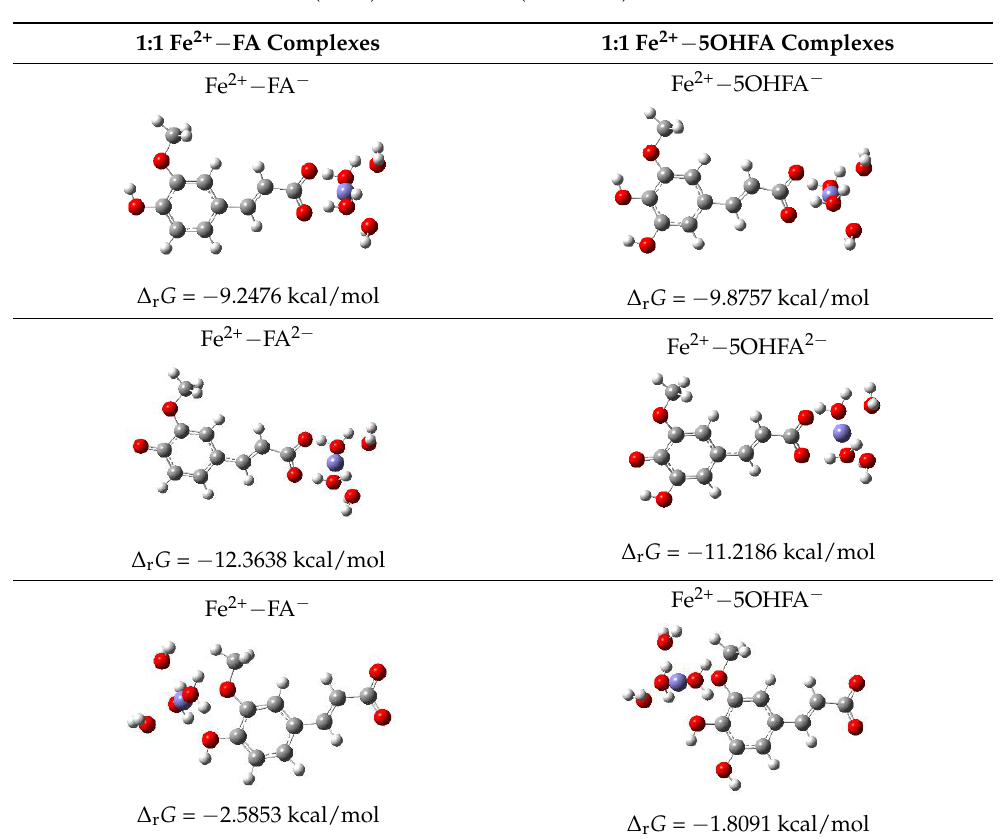
Table 4. Structures of complexes and reaction Gibbs free energies ( ∆ r G ) of the complexation reactions between the Fe 2+ ion with FA − (FA 2 − ) and 5OHFA − (5OHFA 2 − ) in stoichiometric ratios of 1:1 and 1:2.